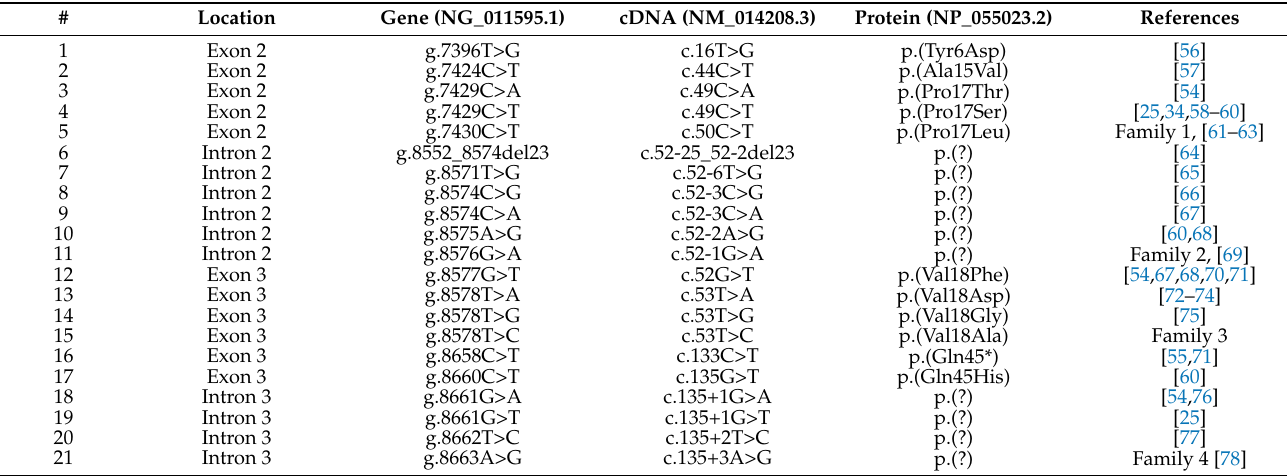
Table 1. 5 (cid:48) - DSPP (N-terminal) Disease-Causing